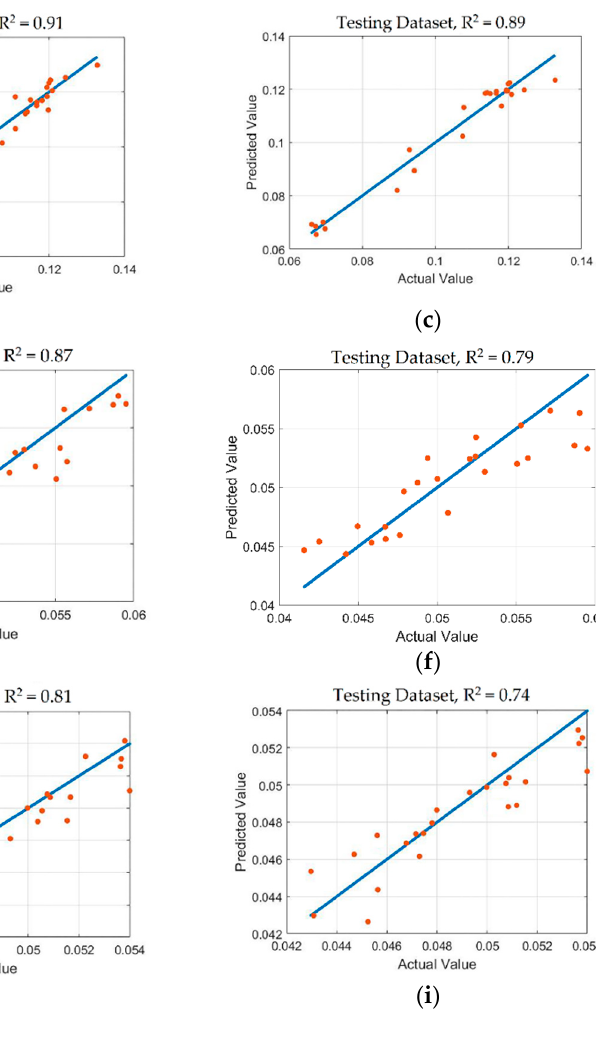
Figure 5. Scatter diagram of prediction of TPs, FAA, and CAF content. ( a – c ) TPs content prediction results obtained by CARS-SVM, CARS-PLS, and CARS-RF models; ( d – f ) FAA content prediction results obtained by CARS-SVM, CARS-PLS, and CARS-RF models; ( g – i ) CAF content prediction results obtained by CARS-SVM, CARS-PLS, and CARS-RF models.